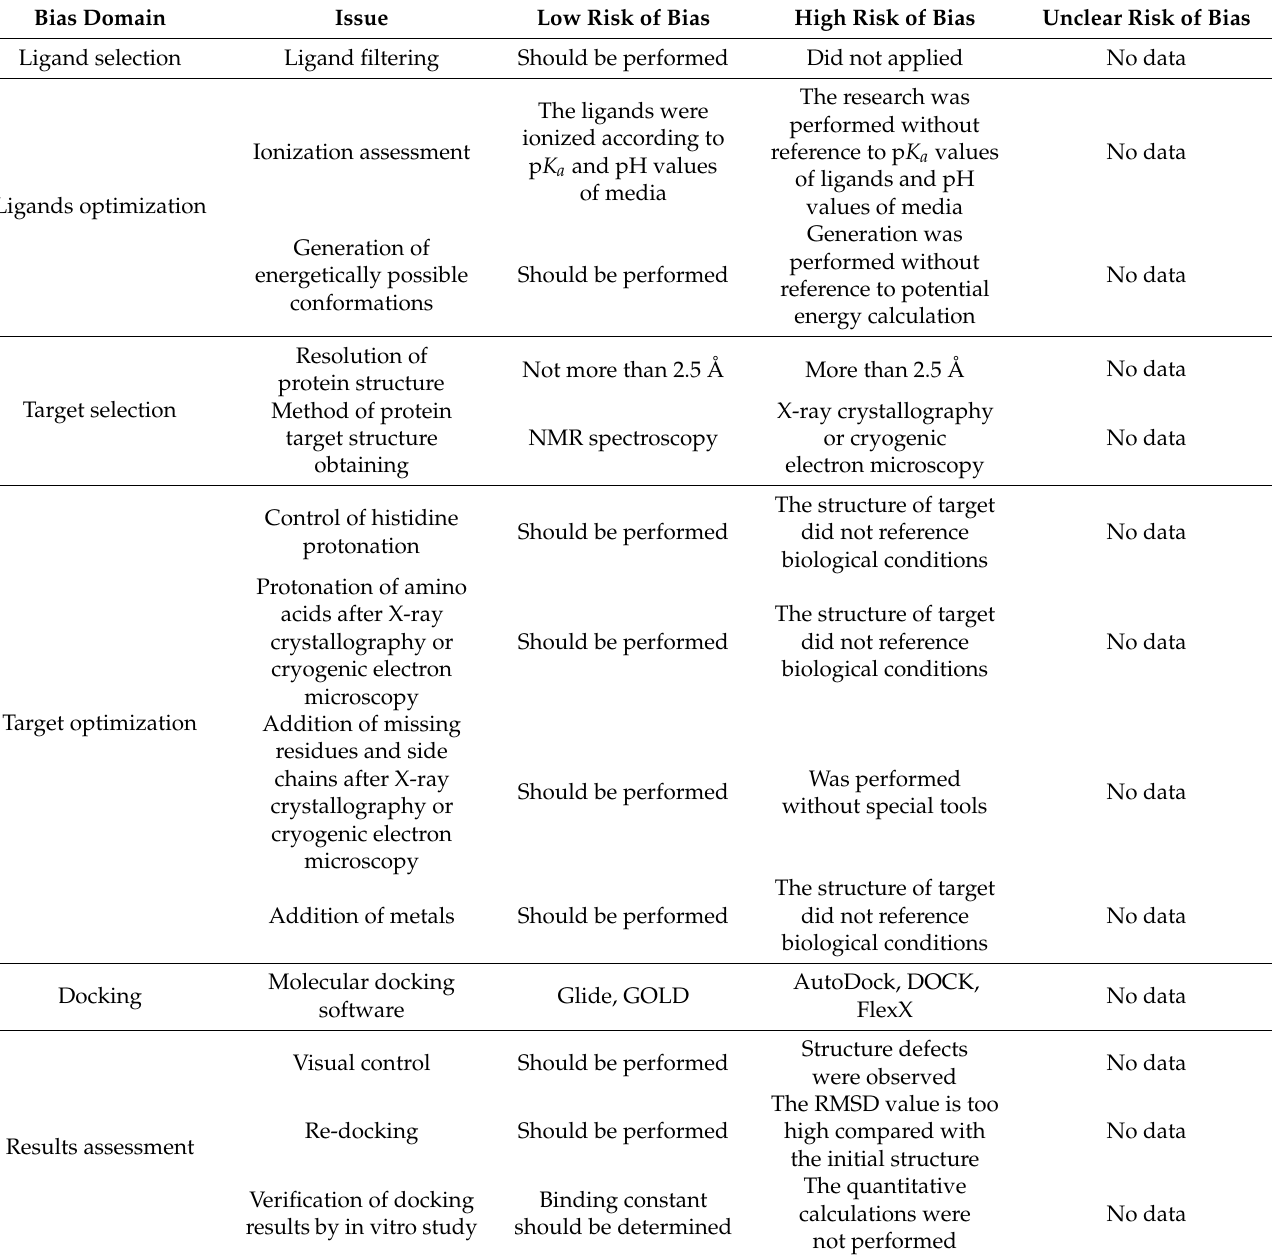
Table 2. Overall inclusion and exclusion criteria for publication